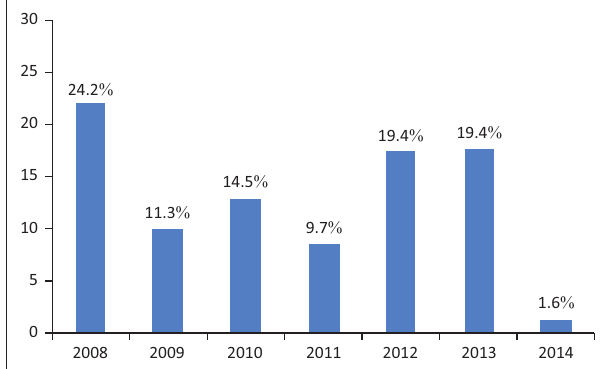
FIGURE 2: Prevalence of HIV in HIV-exposed infants over the years